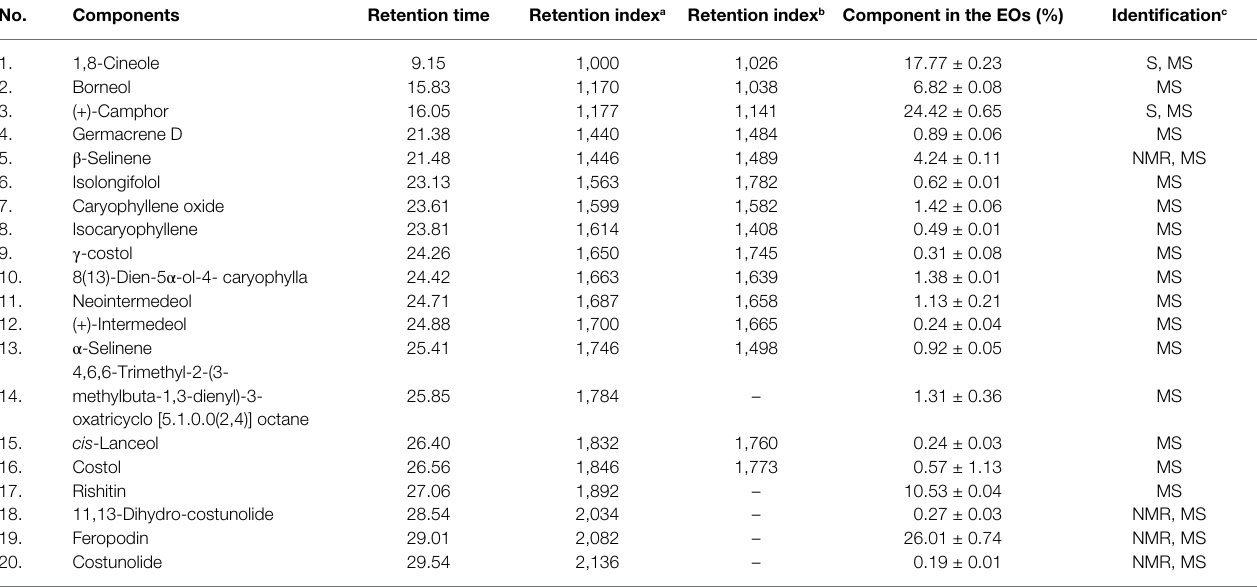
TABLE 1 | Chemical constitutes of the EOs extracted from A. nakaii.